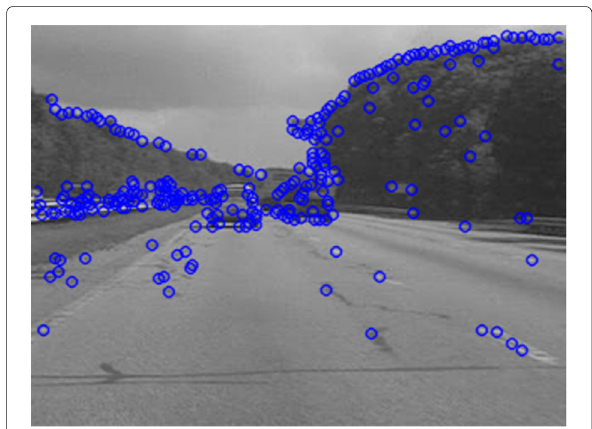
Fig. 2 Detection of keypoints between adjacent